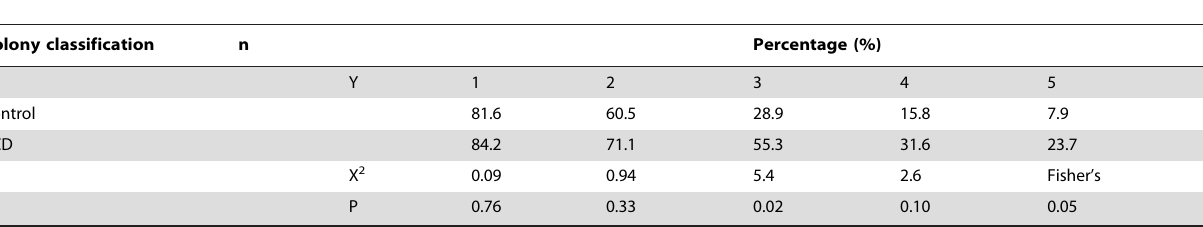
Table 8. Percentage of Control and CCD colonies infected with Y or more viruses.